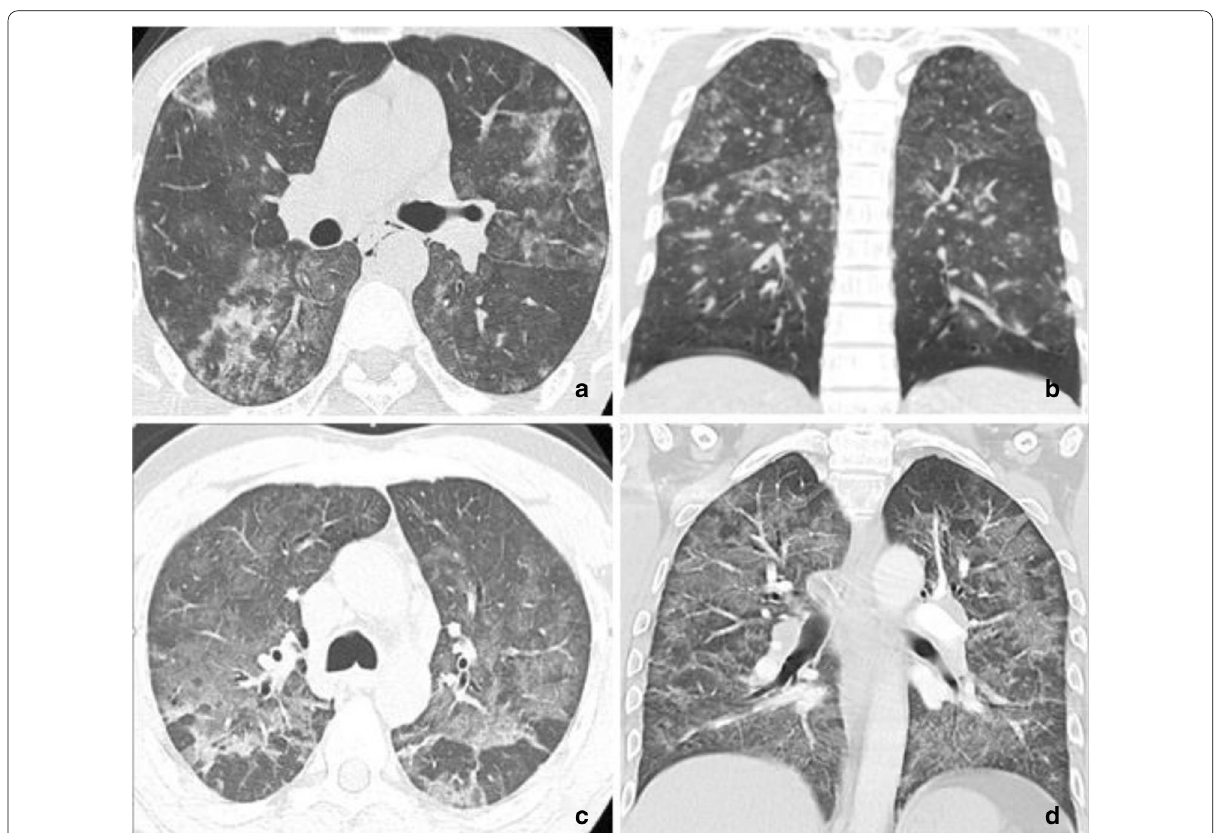
Fig. 10 Non‑infectious mimickers of indeterminate COVID‑19. a , b A 33‑year‑old bird breeder with subacute hypersensitivity pneumonitis, axial and coronal reformatted CT images shows patchy or diffuse bilateral ground‑glass opacities associated with poorly defined centrilobular nodules and lobular areas of reduced attenuation indicative of air trapping. c , d A 38‑year‑old man with acute eosinophilic pneumonia, axial and coronal reformatted CT images shows multifocal non‑rounded GOO associated with inter‑ and intralobular septal thickening and thickened bronchovascular